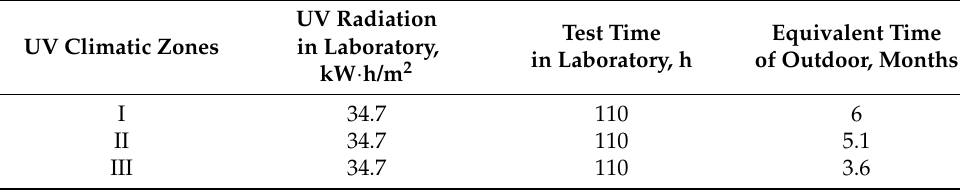
Table 3. Equivalent time of outdoor under the same UV radiation and test time.